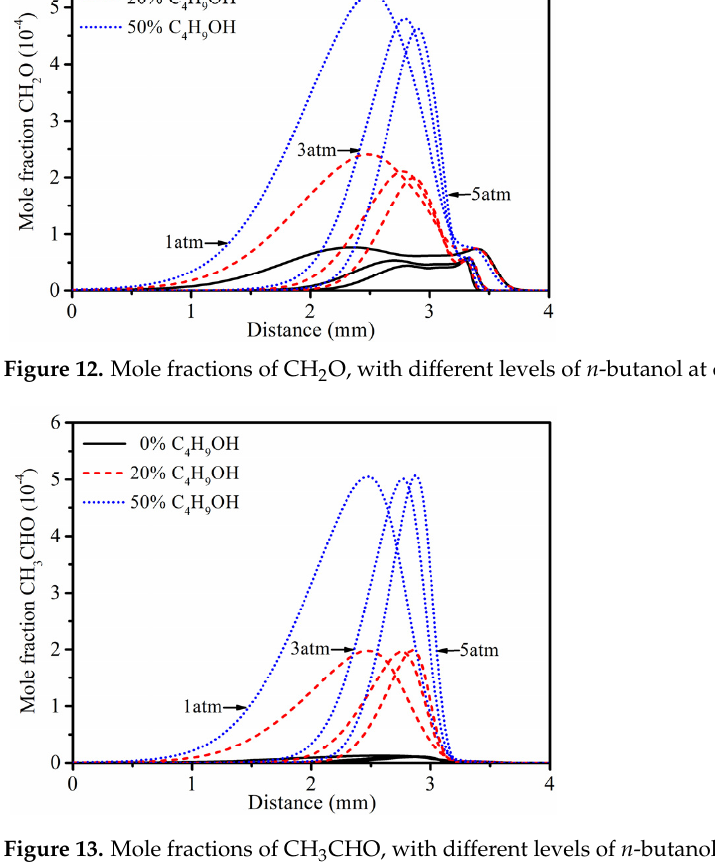
Figure 13. Mole fractions of CH 3 CHO, with different levels of n -butanol at different pressures.